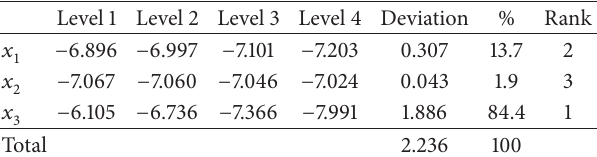
Table 6: Analysis results on the effect of the design variables on the mass.